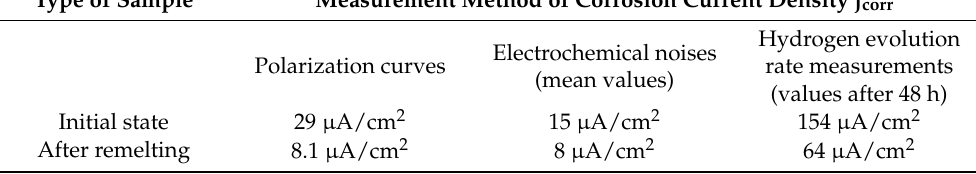
Table 3. Comparative list of corrosion current density values determined by different measure- ment methods.